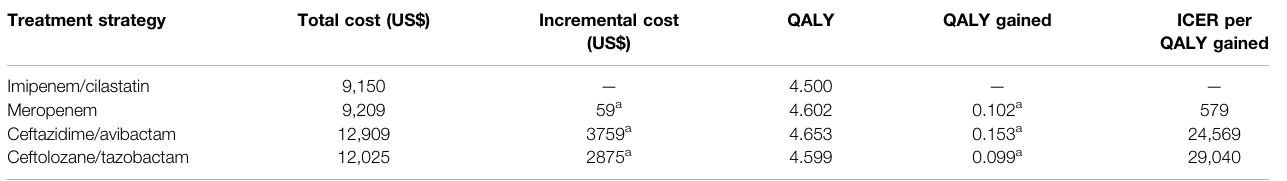
TABLE 2 | Cost-effectiveness of four strategies for cUTI patients due to Enterobacteriaceae infection. Treatment